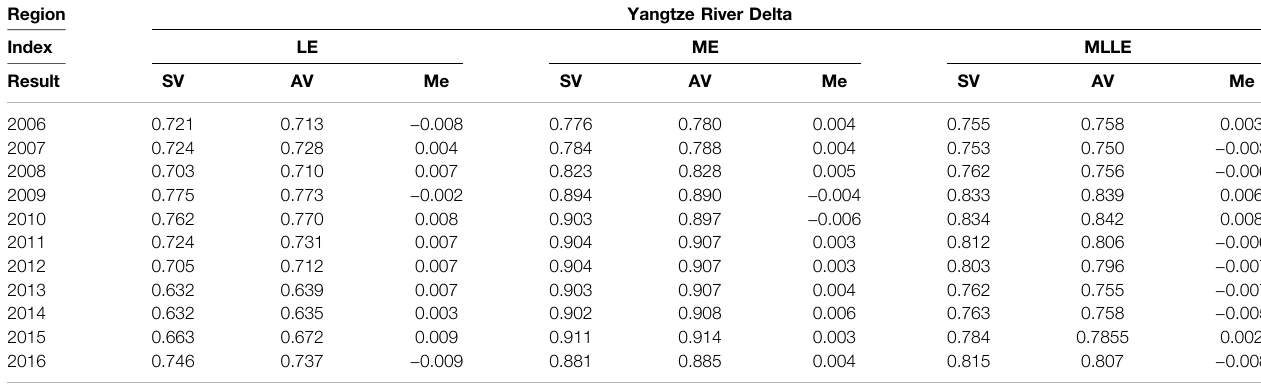
TABLE 9 | Network training error test of the ef fi ciency of two industries linkage development in the Yangtze River Delta from 2006 to 2016. Region